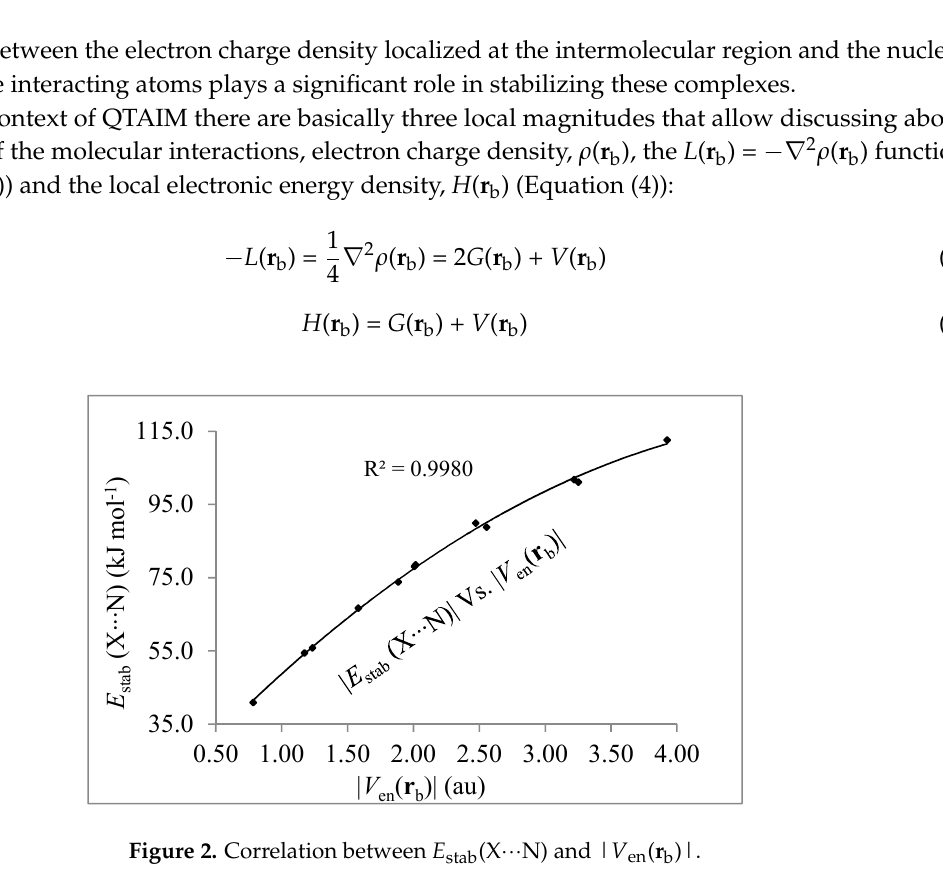
Table 3. Electronic localization and delocalization indices. Complexes